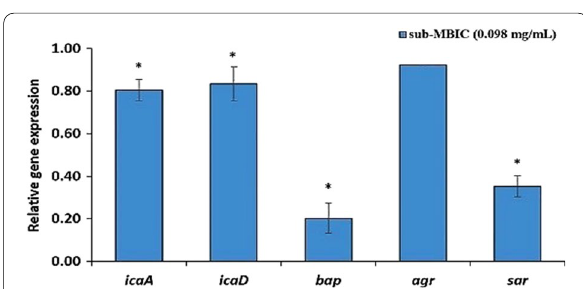
Fig. 3 Effect of sub-MBIC concentration of the extract of M. communis on the expression of icaA , icaD , bap , sar , and agr genes in Sa12 strain. Gene expression data were normalized to the 16 S